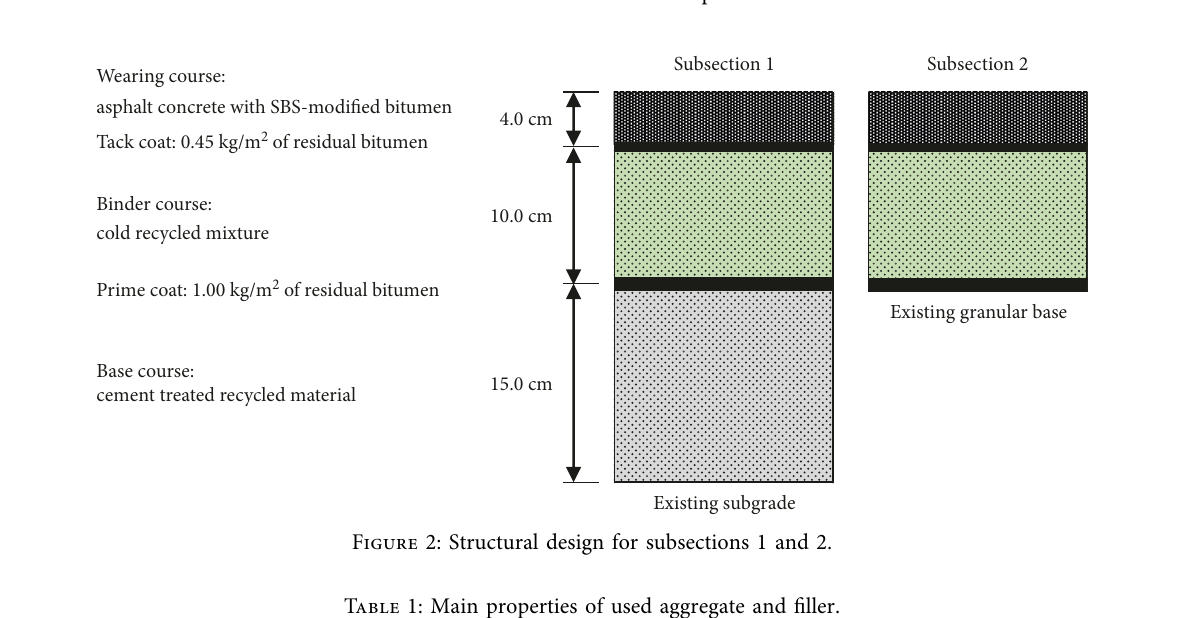
Figure 1: Plan view of the instrumented pavement section.